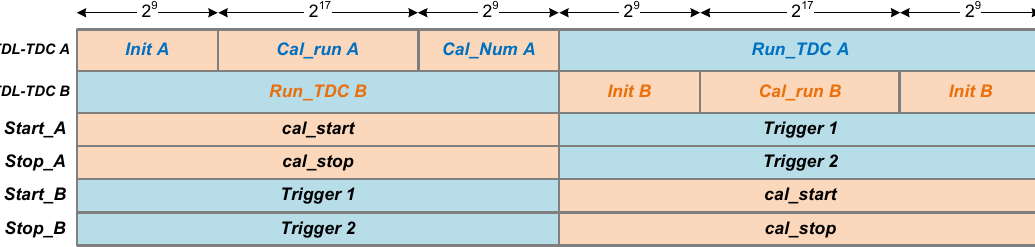
Figure 5. Timing flow of the calibration in the proposed